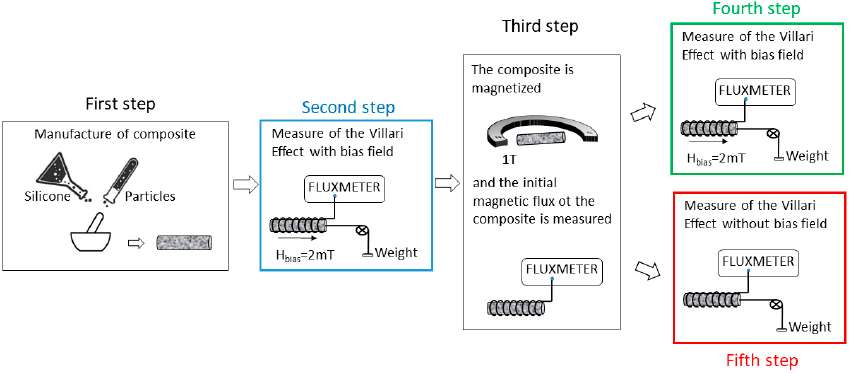
Figure 2. Scheme of Villari measurements.